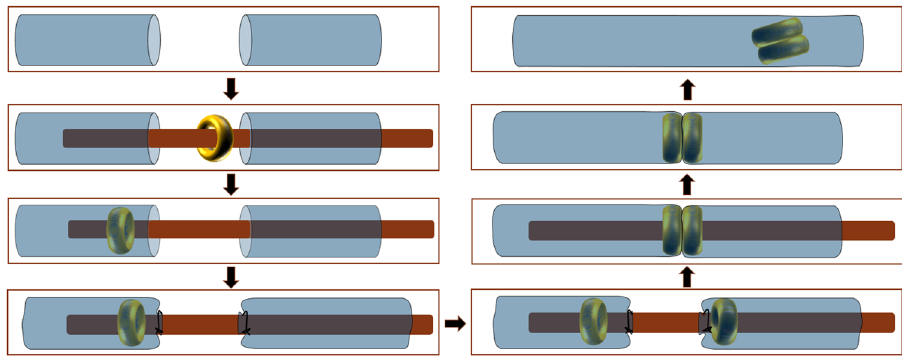
Figure 2. Schematic presentation of the colonic anastomosis using magnetic compression 13